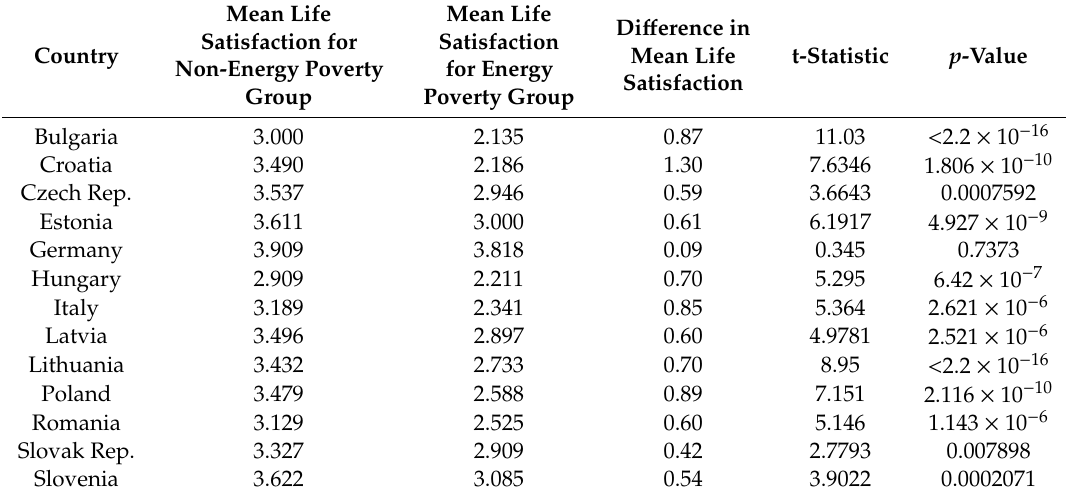
Table 2. Welch two-sample t-tests for mean di ff erences by country. Mean Mean Life Satisfaction for Non-Energy Poverty Group